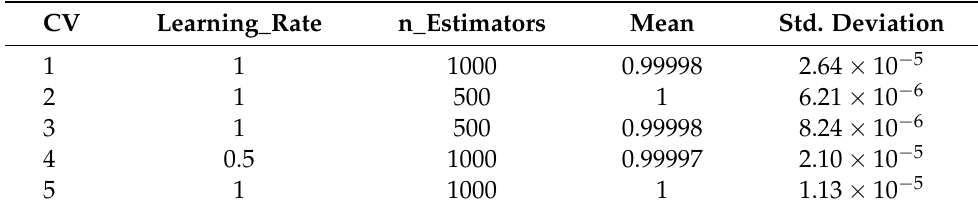
Table 4. Best AdaBoost model by